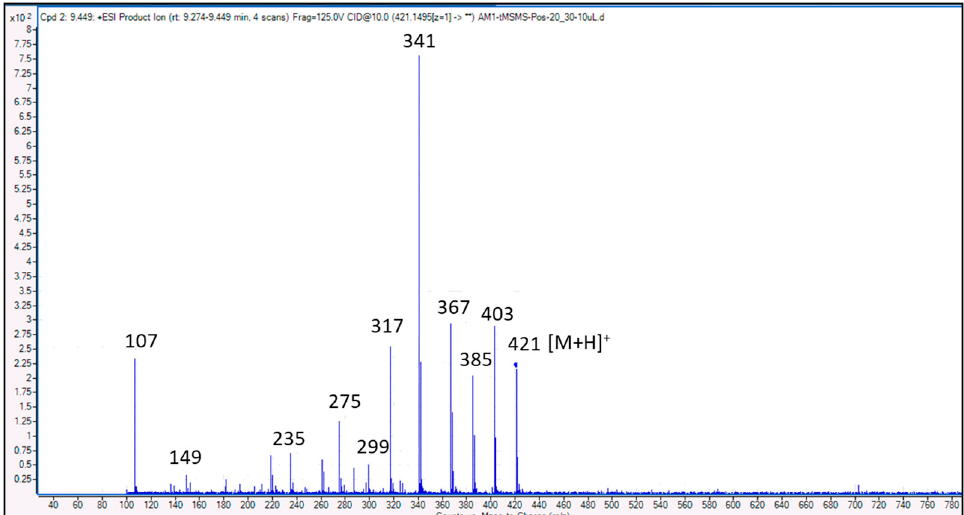
Figure 6. MS/MS spectrum of afzelechin 3- O -alpha- L -rhamnopyranoside.